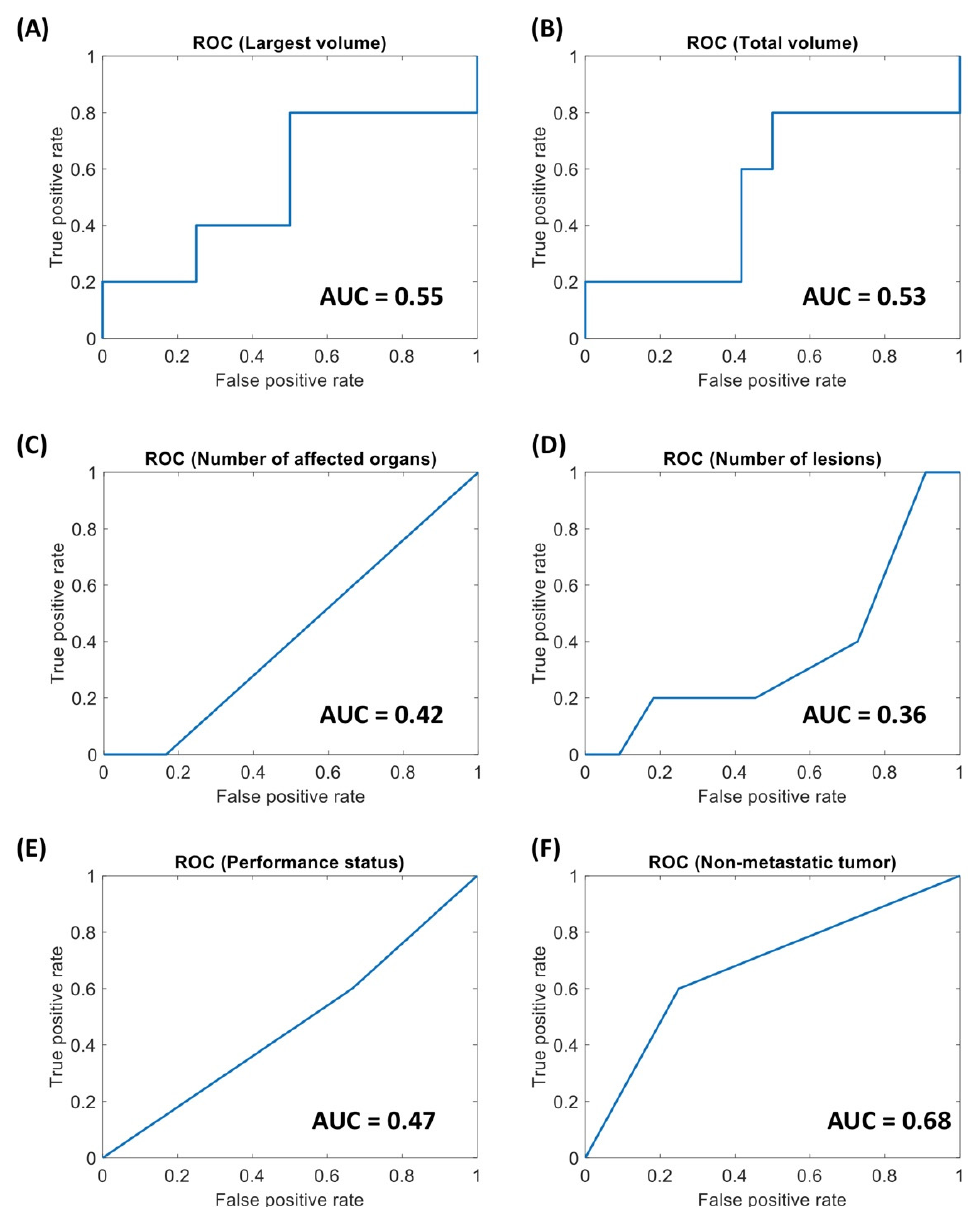
Figure 3. Receiver Operating Characteristics (ROC) curves for the clinical variables considered for the NIVACTOR project. ( A ) Volume of the largest Region Of Interest (ROI). ( B ) Total tumor volume. ( C ) Number of affected organs. ( D ) Number of lesions. ( E ) Performance status. ( F ) Non-metastatic status.